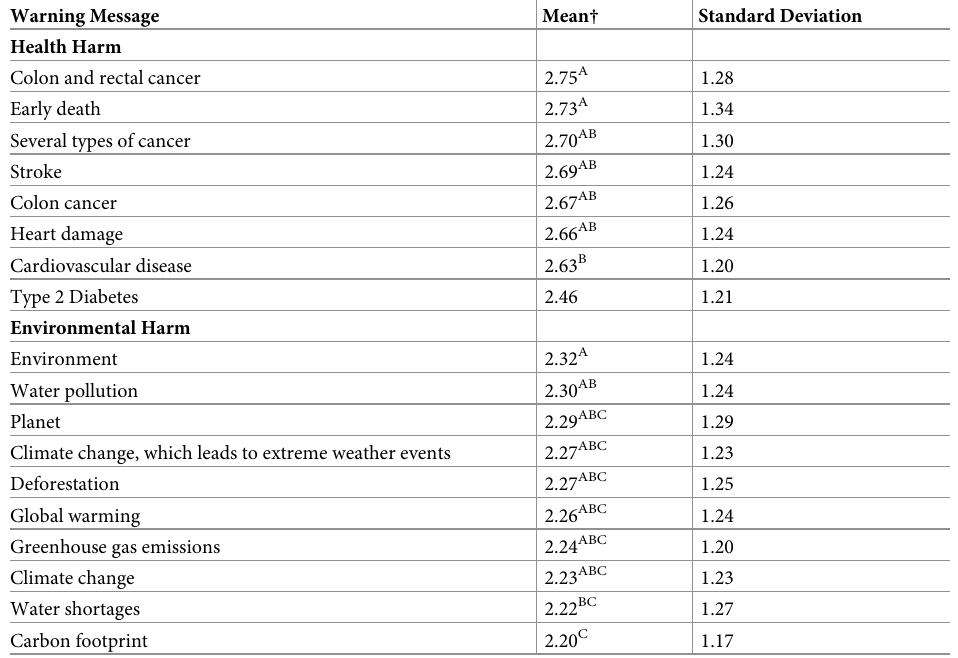
Table 5. Perceived message effectiveness (PME) � of health and environmental harms, in descending order of PME, from an online experiment among 1,199 U.S. adults (March 2020). Warning